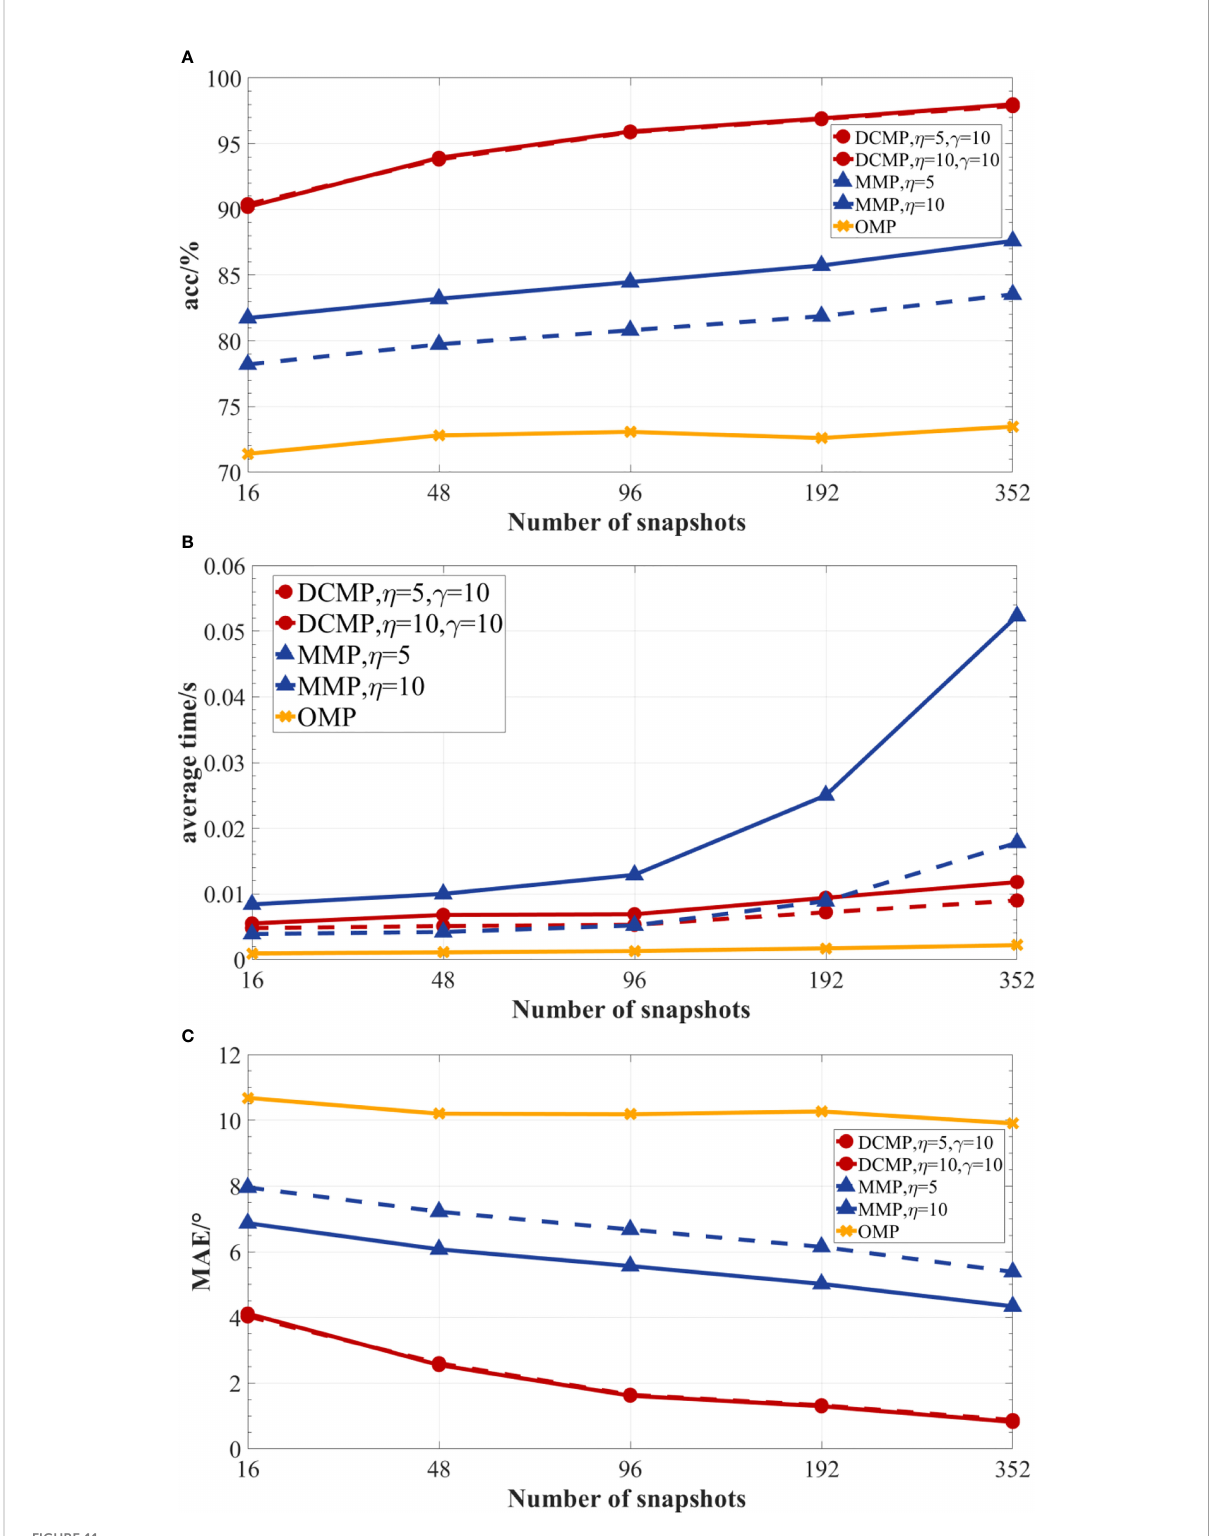
FIGURE 11 The performances of the DCMP, MMP, and OMP algorithms for a different number of snapshots under the SNR of 20 dB, two sources, and a 12- element array. (A) DOA prediction accuracy; (B) average estimation time; (C)